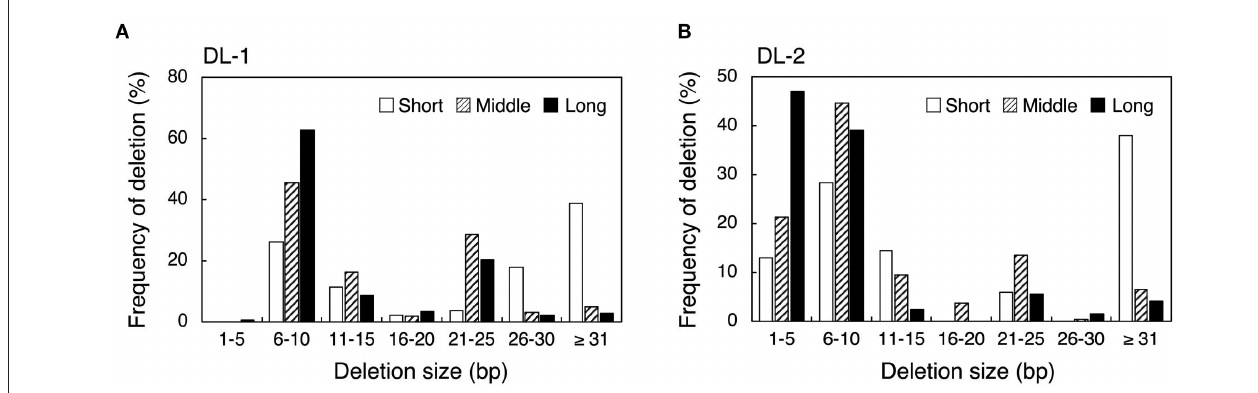
FIGURE 2 | Comparison of deletion sizes using crRNA with guide sequences of different lengths at DL-1 (A) and DL-2 (B) target sites. Deletion size and mutation number were detected by targeted amplicon sequencing. Frequency of deletion means the percentage of deletions within the range of each deletion size per total number of deletion